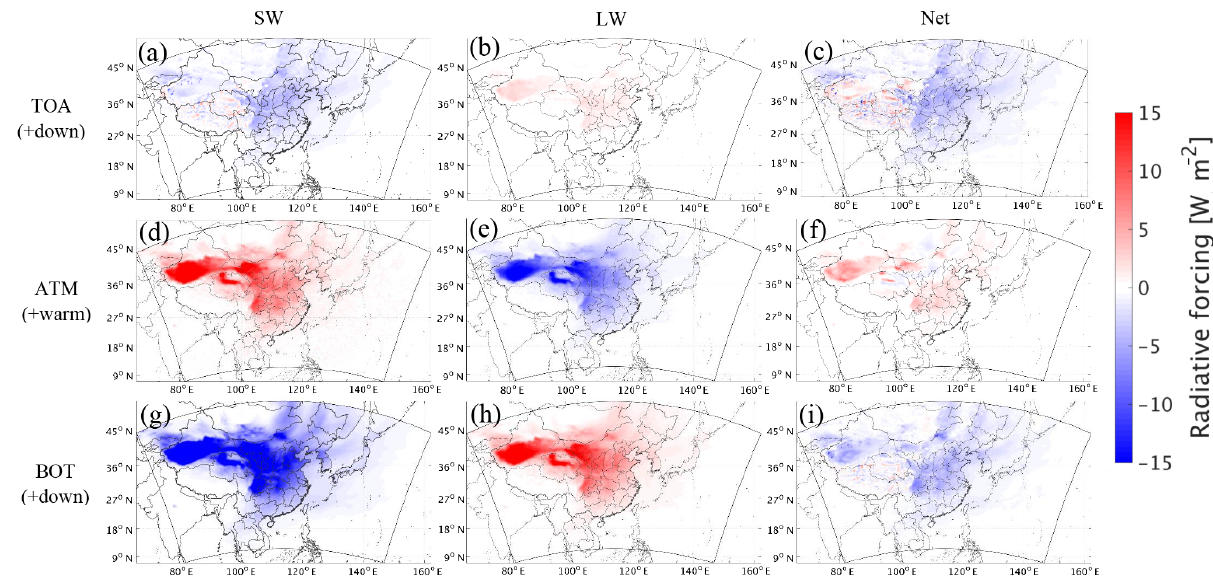
Figure 7. Spatial distributions of the clear-sky SW (left panels), LW (middle panels), and net (right panels) radiative forcing at the top of the atmosphere (TOA, a–c ), within the atmosphere (ATM, d–f ), and at the bottom of the atmosphere (BOT, g–i ).